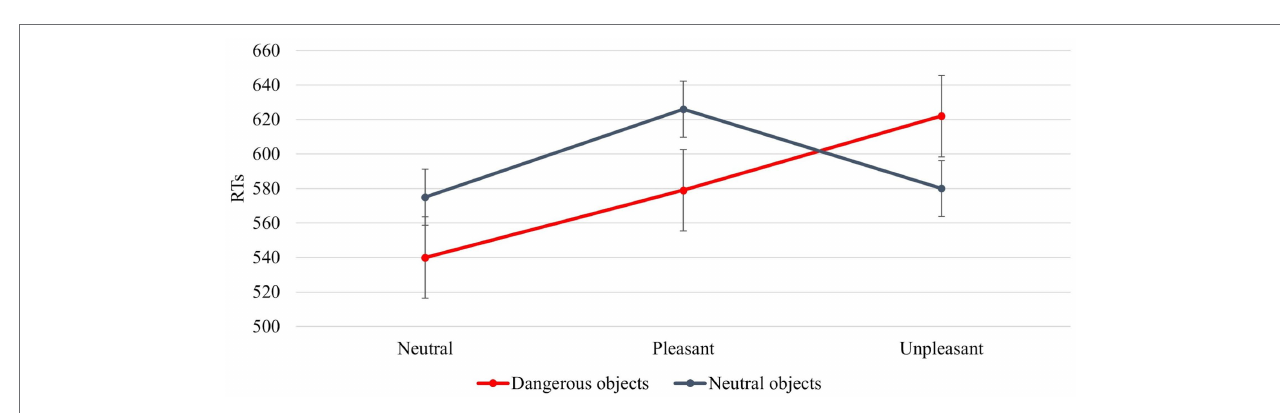
FIGURE 7 | The significant interaction between Object Dangerousness and IAPS Type . Values are in milliseconds and bars represent the standard